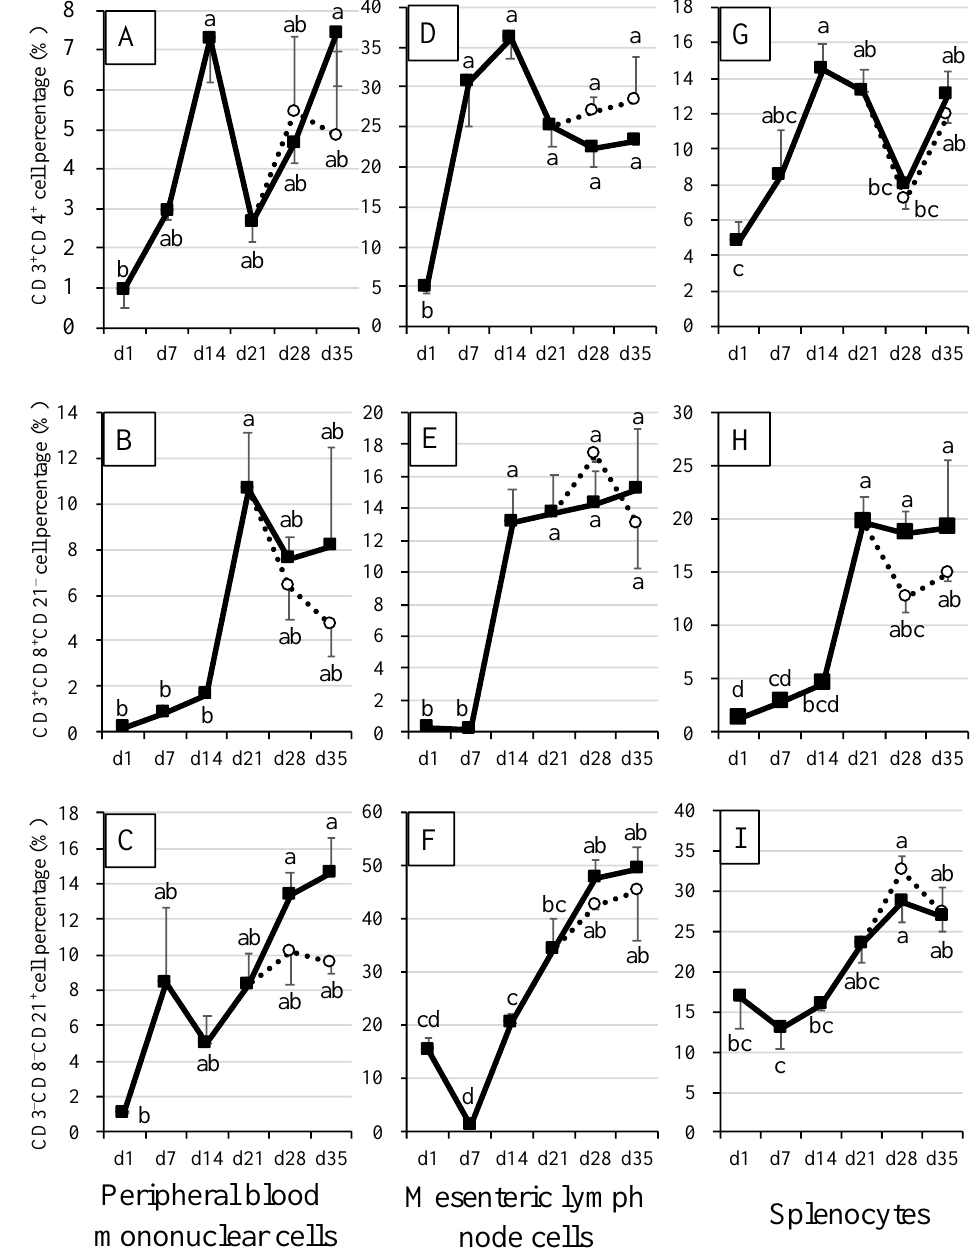
Figure 3. Immune cells in peripheral blood mononuclear cells (PBMC), mesenteric lymph node (MLN) cells and splenocyte of piglets and their association with adaptive immunity. CD3 + CD4 + cells were considered as helper T cells, CD3 + CD8 + CD21 – cells as killer T cells, and CD3 – CD8 – CD21 + cells as B cells. Closed squares indicate the mean values for suckling piglets. Open circles indicate the mean values for piglets weaned at 21 days of age. The error bars represent the standard errors. Different superscripts indicate significant differences between groups. Panel ( A ), helper T cell population in PBMC. Panel ( B ), killer T cell population in PBMC. Panel ( C ), B cell population in PBMC. Panel ( D ), helper T cell population in MLN cells. Panel ( E ), killer T cell population in MLN cells. Panel ( F ), B cell population in MLN cells. Panel ( G ), helper T cell population in splenocytes. Panel ( H ), killer T cell population in splenocytes. Panel ( I ), B cell population in splenocytes. In MLN of both suckling and weaned piglets, the percentages of helper T cells markedly increased ( p < 0.05) from S1D to S14D, after which they slightly